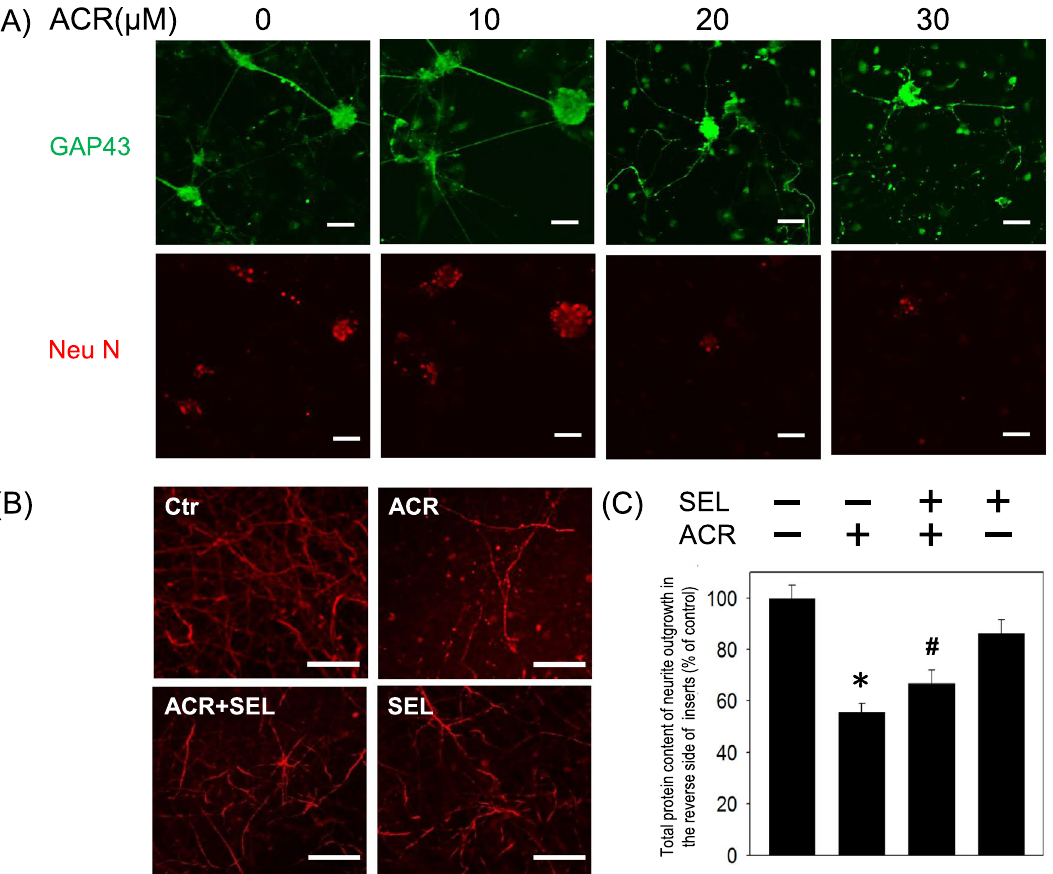
Figure 4. Effect of selumetinib on acrolein-induced reduction in neurite outgrowth. ( A ) Primary cultured cortical neurons (3 × 10 5 cells in a 35 mm petri dish containing coverslips) were treated with acrolein (0–30 μM) for 24 h. Representative immunofluorescent data using GAP-43 antibody show the effect of acrolein on neurite outgrowth. Caliber: 50 μm. ( B ) Primary cultured cortical neurons were cultured in Transwell inserts and treated with acrolein (30 μM) with/without selumetinib (SEL, 10 μM) for 24 h. Representative immunofluorescent data using MAP-2 antibody show the neurites on the reverse side of the Transwell insert. Caliber: 50 μm. ( C